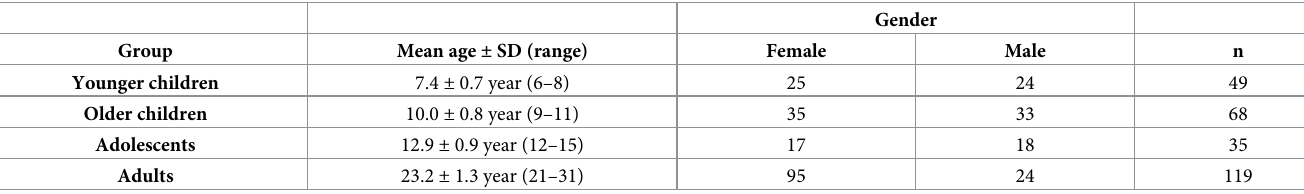
Table 1. Main demographic characteristics of the study’s